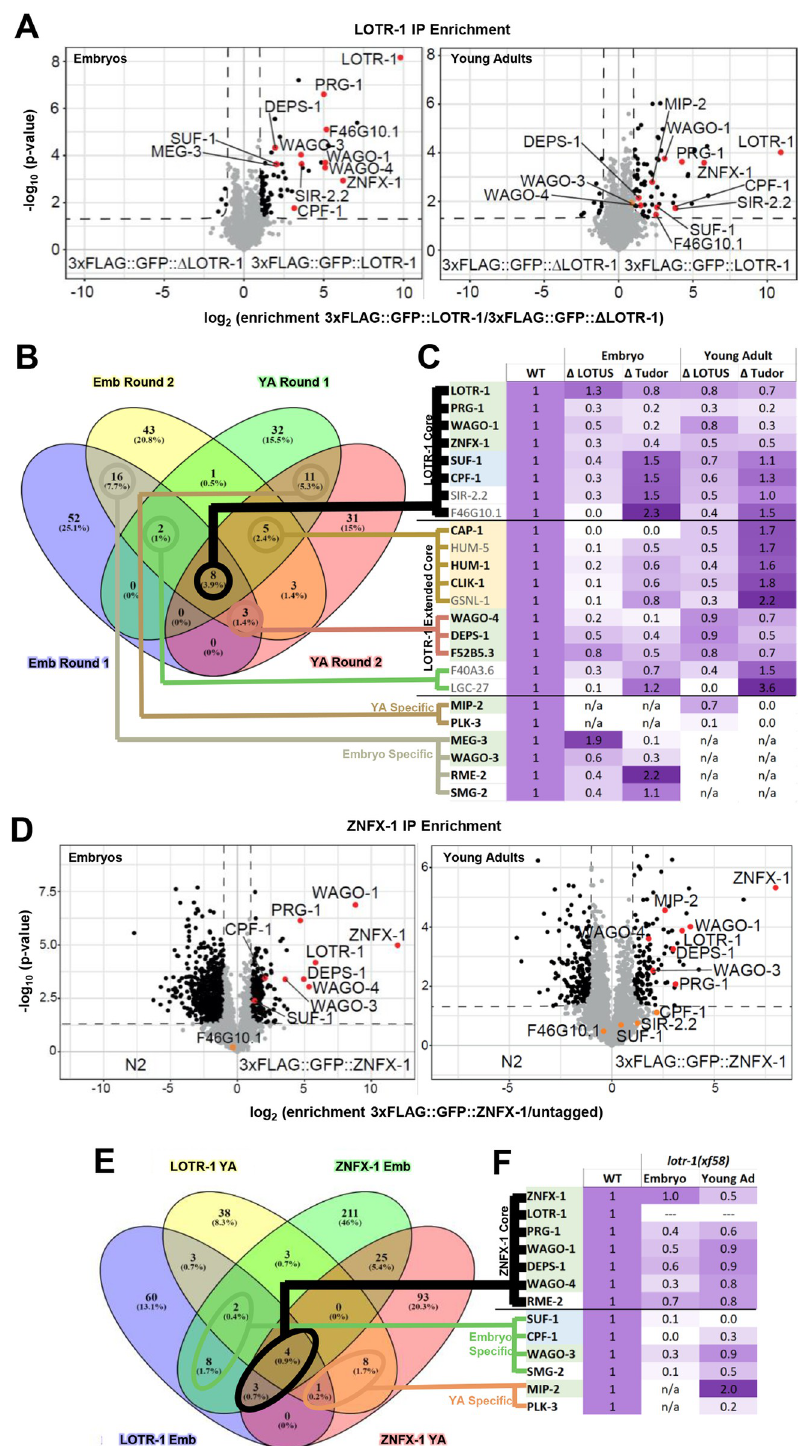
Fig 3. Quantitative IP-mass spectrometry analysis of LOTR-1 and ZNFX-1 immunoprecipitations. A) Volcano plots show the significance and enrichment of proteins that immunoprecipitated with 3xFLAG::GFP::LOTR-1 over the lotr-1 deletion expressing GFP::3xFLAG alone, as identified by qMS. B) Venn diagram shows significantly enriched proteins that overlapped between two rounds of LOTR-1 IP-qMS from both embryo and young adult lysates. C) Table showing the change in LOTR-1 association in embryos and young adults when LOTUS or Tudor domains